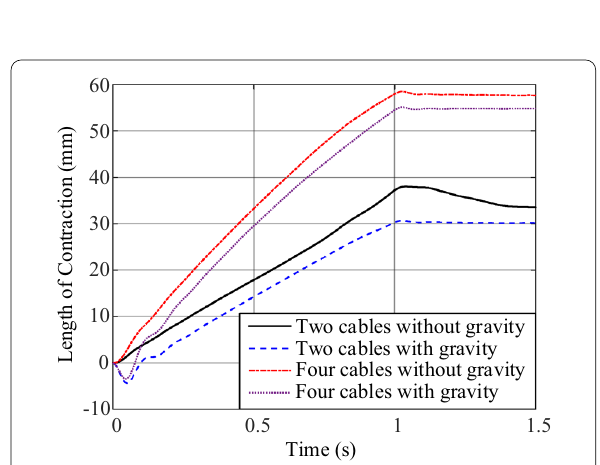
Figure 7 Time change of contraction length in